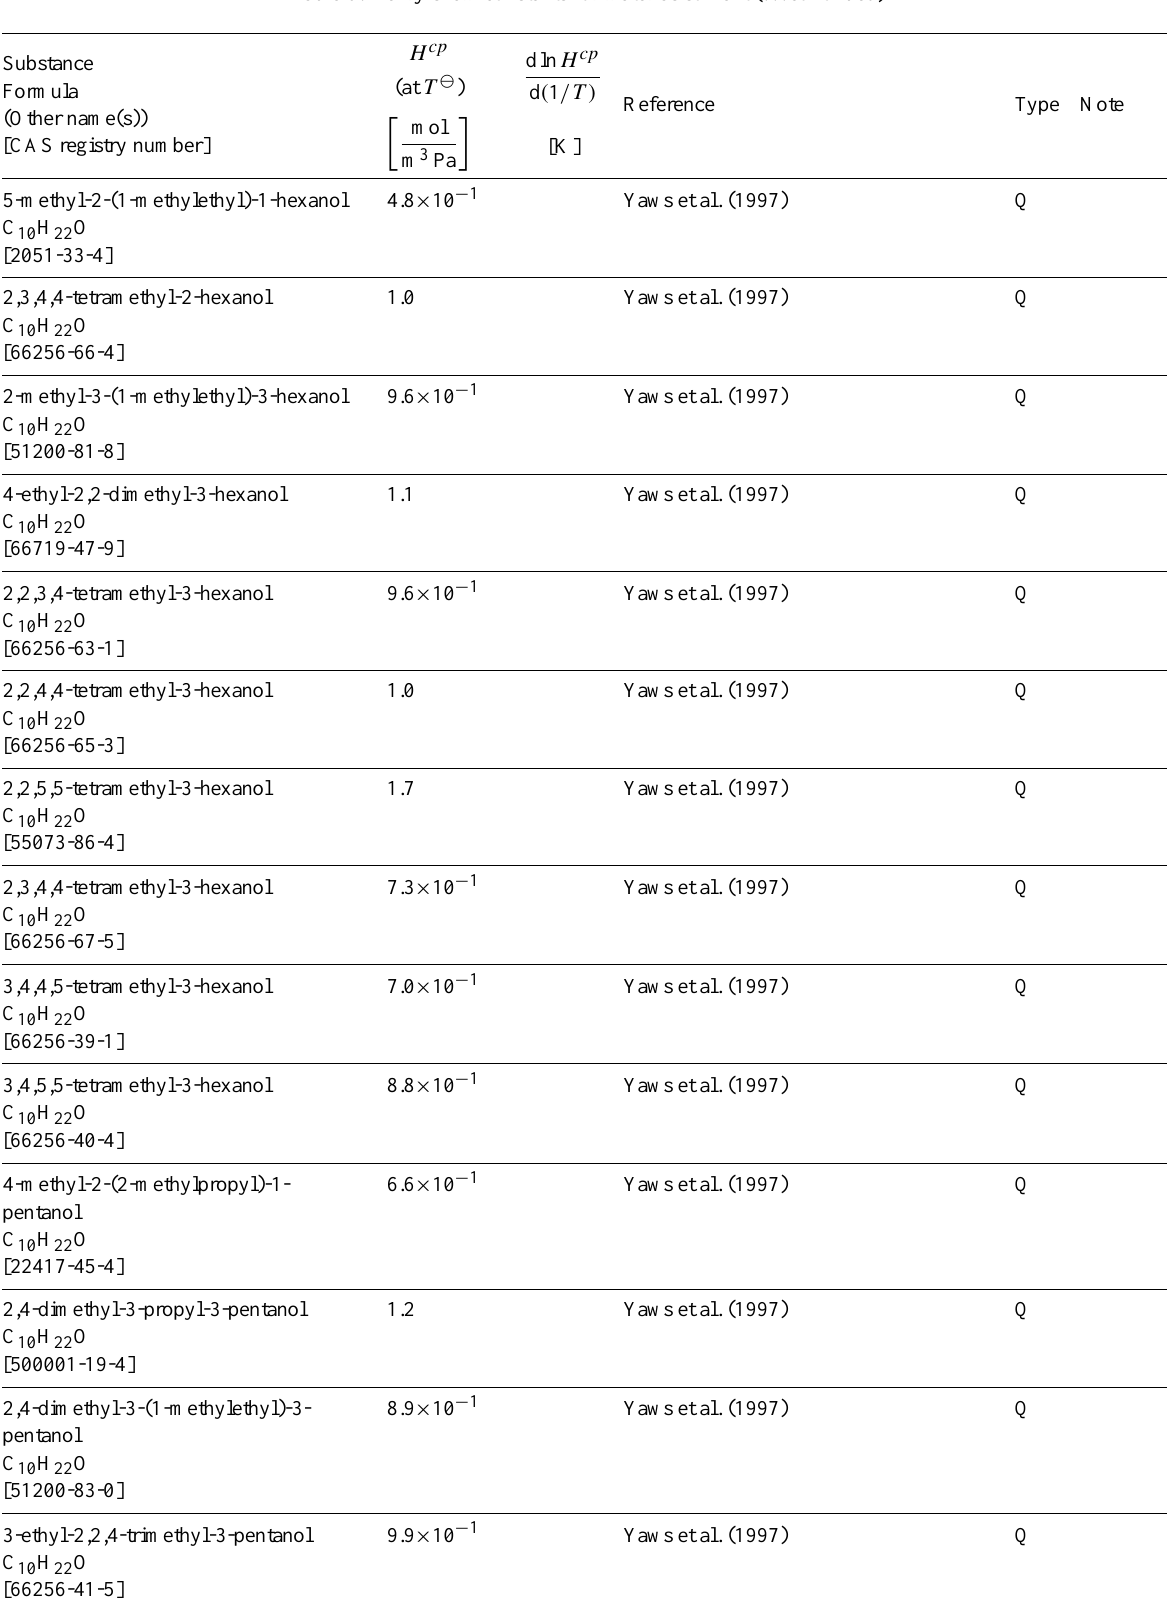
Table 6: Henry’s law constants for water as solvent